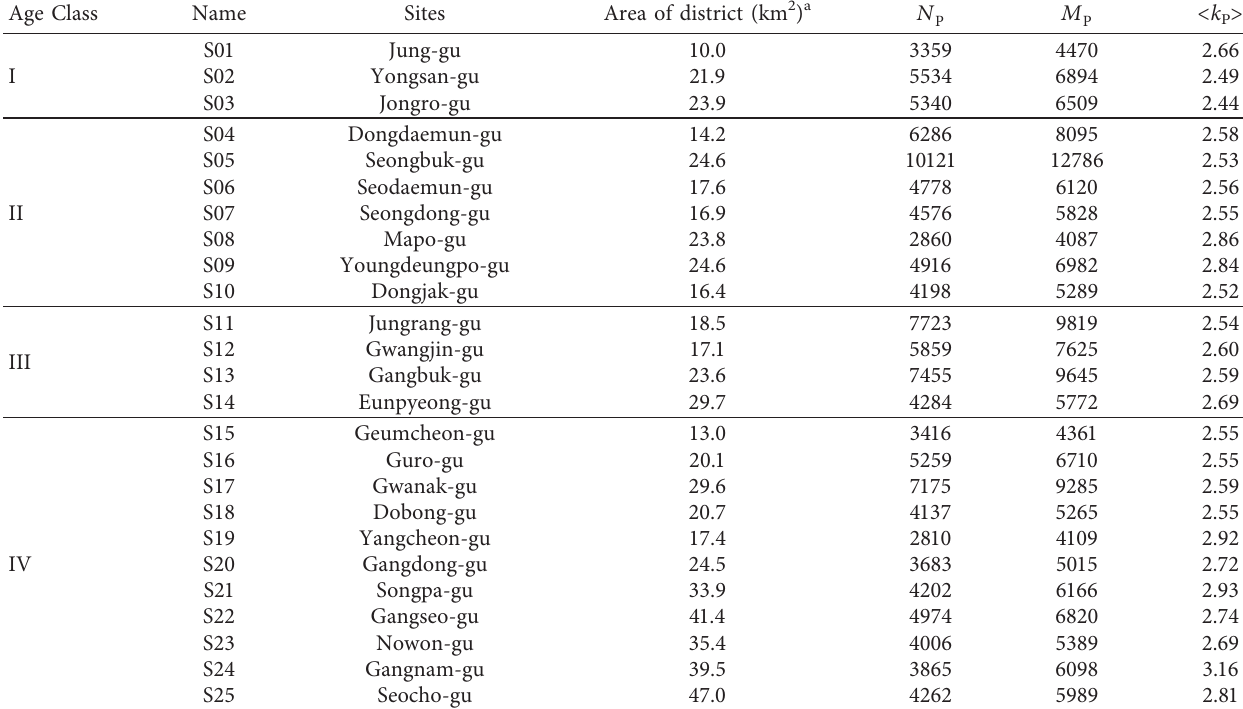
Table 1: Properties of urban road networks of 25 districts in Seoul, South Korea. N average node degree, respectively, measured in the primal